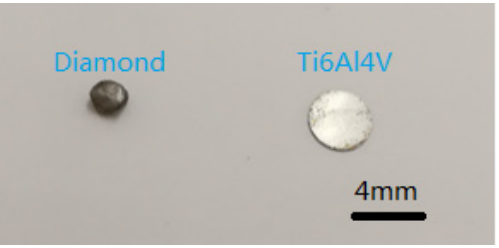
Figure 1. Diamond and Ti–6Al–4V workpiece used in thermal analysis experiment.